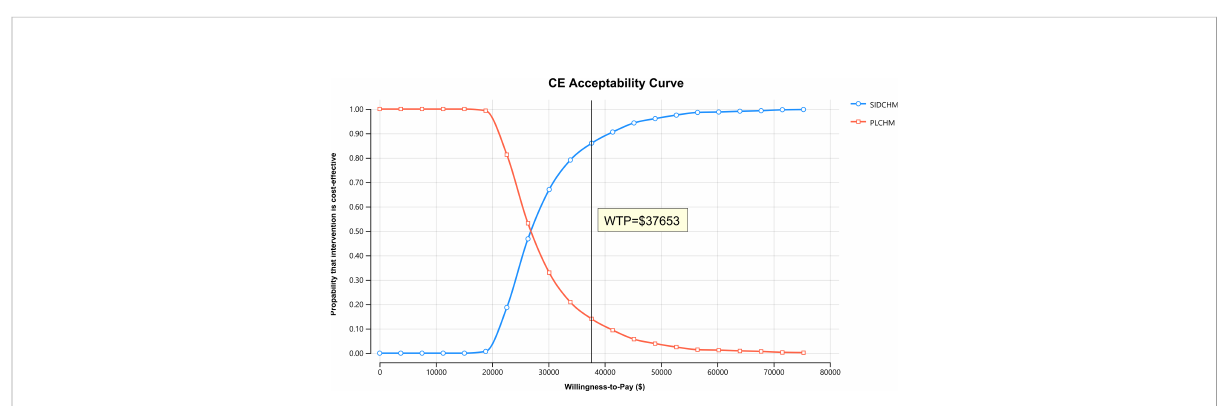
FIGURE 4 The cost-effectiveness acceptability curves for the SIDCHM treatment option compared to the PLCHM treatment option. PLCHM, placebo plus chemotherapy; QALY, quality-adjusted life year; SIDCHM, sintilimab plus chemotherapy; WTP, willingness-to-pay.